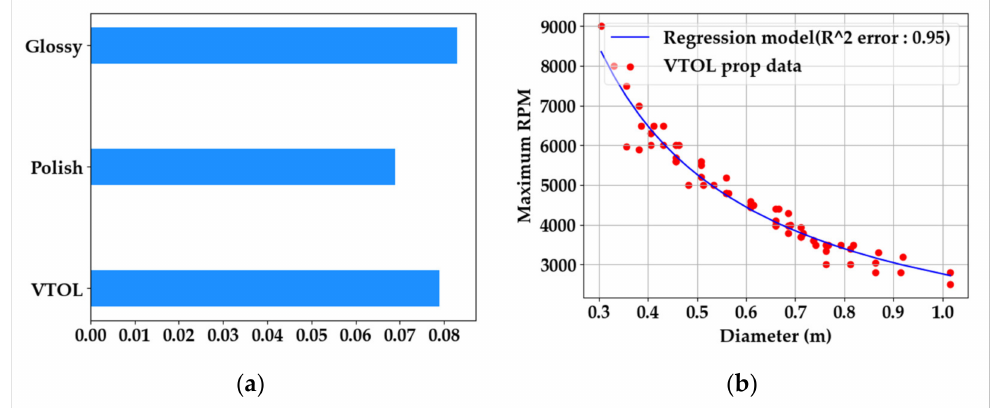
Figure 4. VTOL propeller data: ( a ) the solidity ratio of the T-motor’s VTOL propeller for each series [21]. The average value of solidity was 0.077; ( b ) the regression model for estimating the VTOL propeller’s rpm according to the propeller diameter from the T-motor’s VTOL propeller data [21]. The accuracy of the model was measured by the R -squared error, and the accuracy was high at 0.95. The unit of propeller diameter was in meters